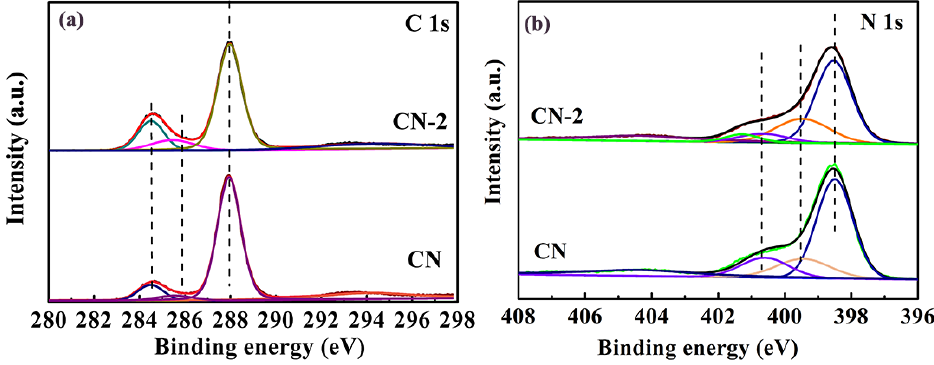
Figure 3. XPS spectra of CN and CN-2: ( a ) C 1 s and ( b ) N 1 s.